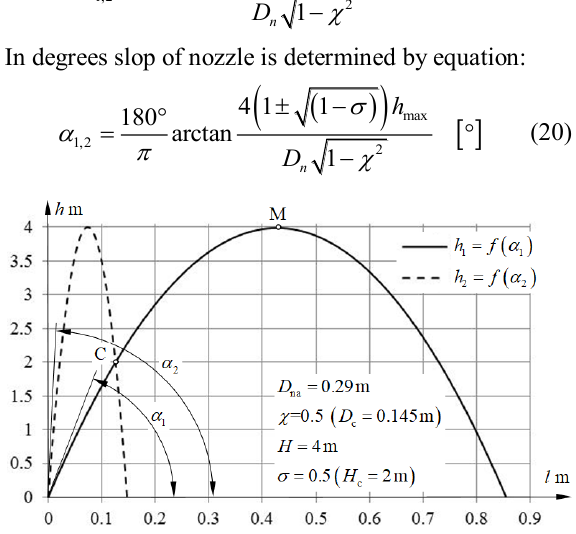
Fig. 4. Jet path on ( l, h ) plane for selected design parameters Fig. 4 shows the path of the water jet flowing from the nozzle at an angle of  determined on the basis of selected design parameters of the